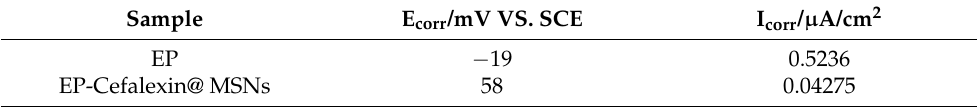
Figure 7. Tafel curves ( a ) and OCP ( b ) of EP and EP-Cefalexin@MSNs in 3.5 wt.% NaCl solution. Table 4. The kinetic parameters of the Tafel curves.